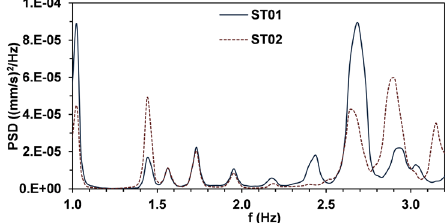
Figure 24. RMSs at Stern’s buttress in radial direction.